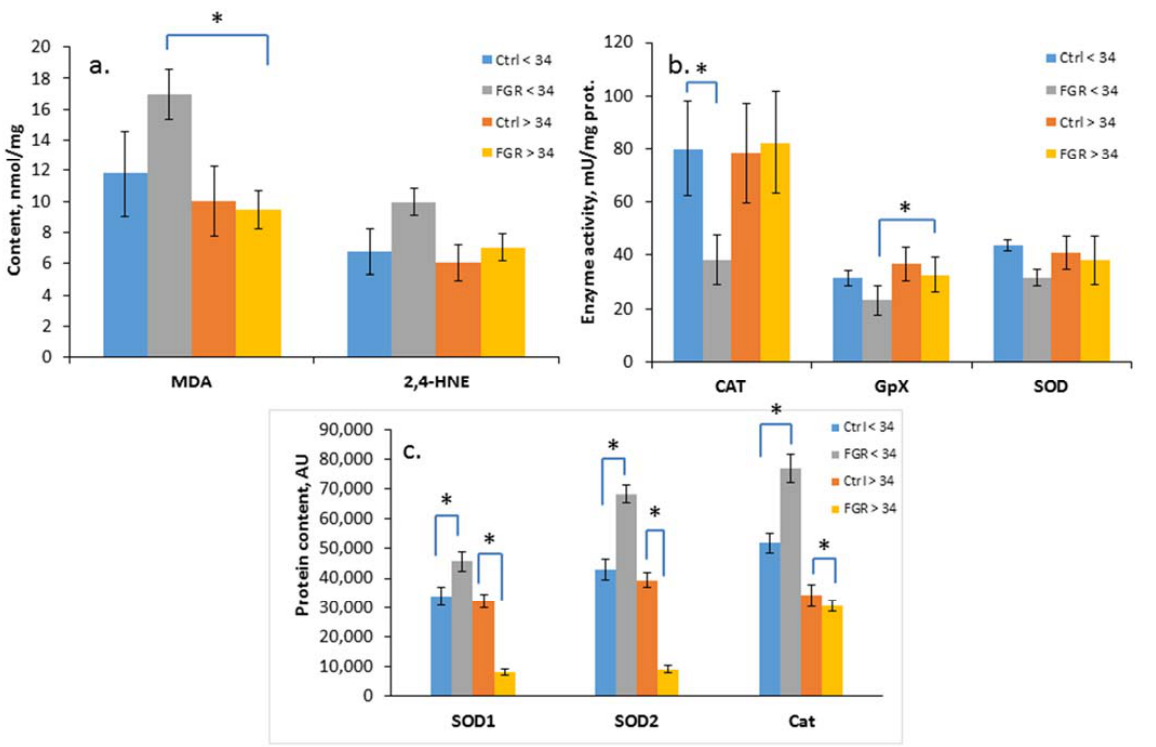
Figure 2. Content of MDA and 4-HNE ( a ); SOD, CAT and GPx activity ( b ); and SOD1, SOD2 and Cat content in the umbilical cord blood plasma of newborns ( c ). Data presented as mean ± SD; *: significance level p ≤ 0.05 (p-adjusted) when compared with the control group of the corresponding gestational age.. Ctrl <> 34 are the control groups of the corresponding gestational age. FGR <> 34 are the groups with FGR corresponding to gestational age. AU is an arbitrary unit.